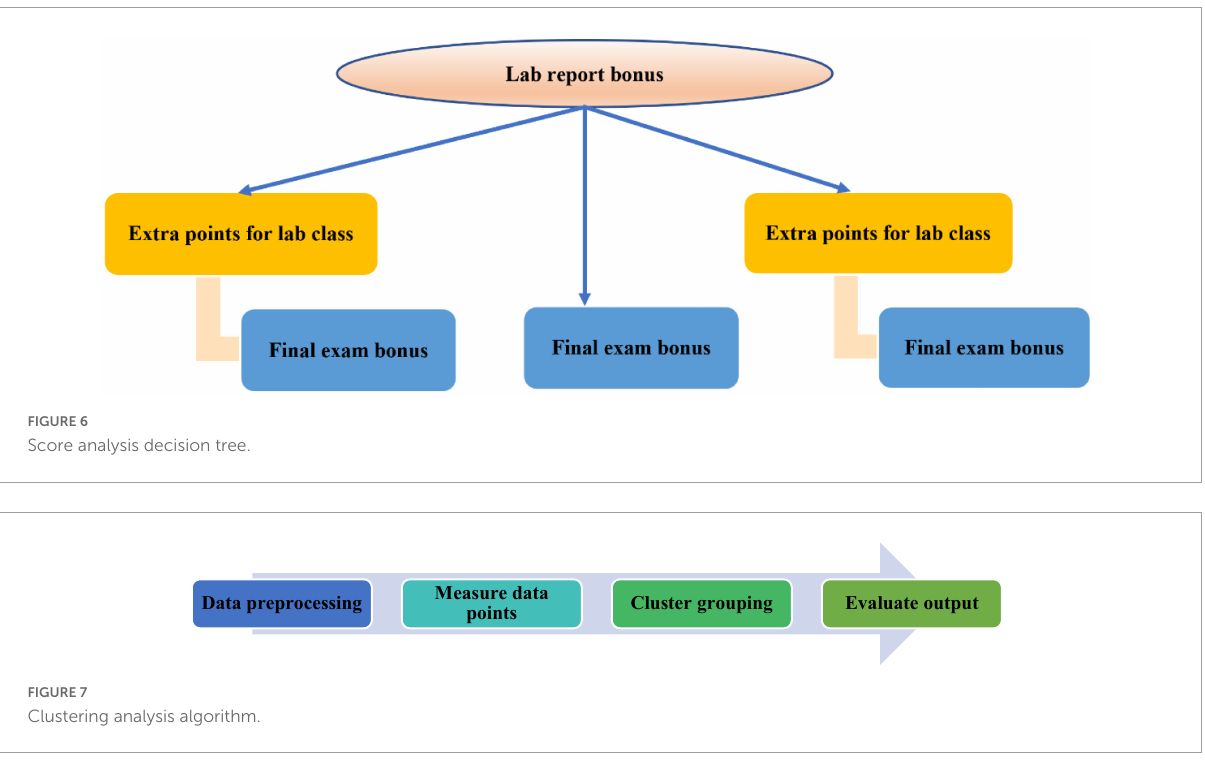
Cluster grouping